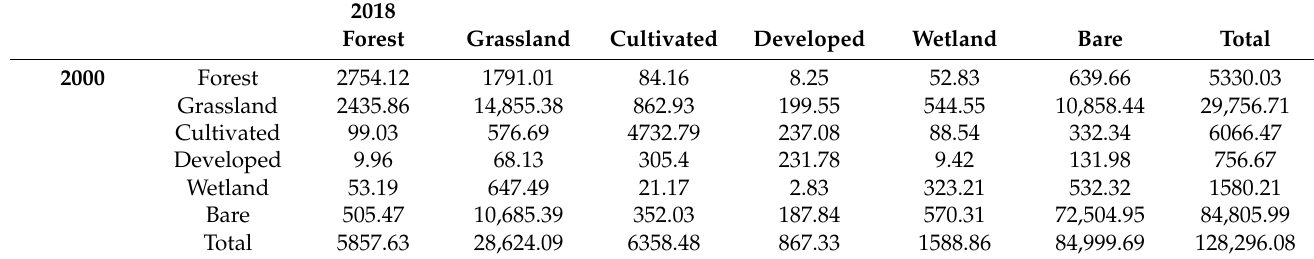
The types of grassland coverage are obtained by RS and GIS (Figure 4). In terms of spatial distribution, the area of low coverage grassland occupied the largest, while the area of high coverage and medium coverage was much smaller. The high-covered grass- land is mainly concentrated in the upper reaches of the Qilian mountains area. In 2000, the medium-covered grassland was mainly concentrated in the middle reaches, while in 2018 the medium-covered grassland was located more in the east of the lower reaches.